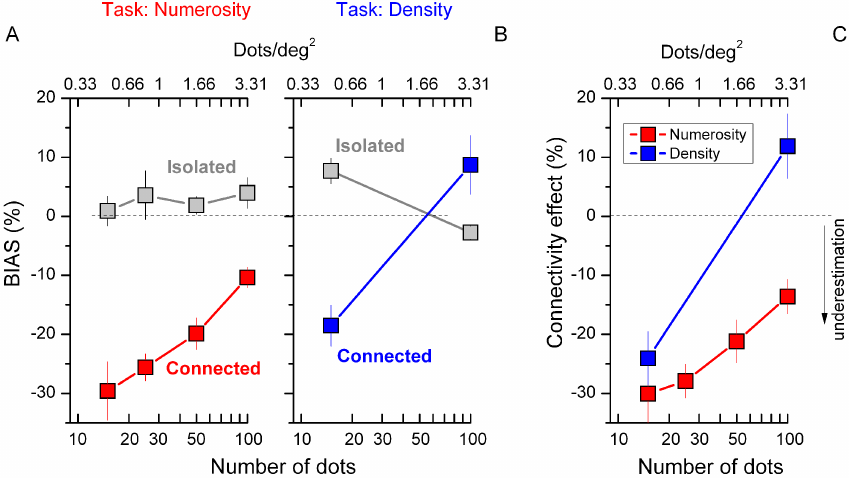
Figure 3. A and B) Average PSEs expressed as percentage difference from the references number/density levels (on the abscissae). The isolated dots condition (baseline) is reported in grey. Numerosity judgements for connected stimuli are shown in red, density judgments in blue. C) Effect of connecting dots expressed as % difference from PSEs in the isolated and connected conditions (colour code as